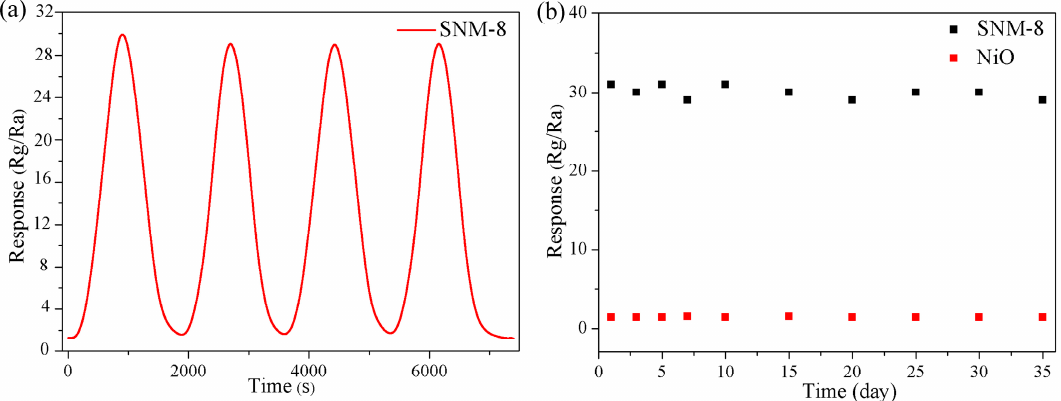
Figure 9. ( a ) Reproducibility of the response of SNM-8 to 10 ppm xylene at 180 ° C; ( b ) Long-term stability tests of the NiO and SNM-8 sensors to 10 ppm xylene at 180 ° C.